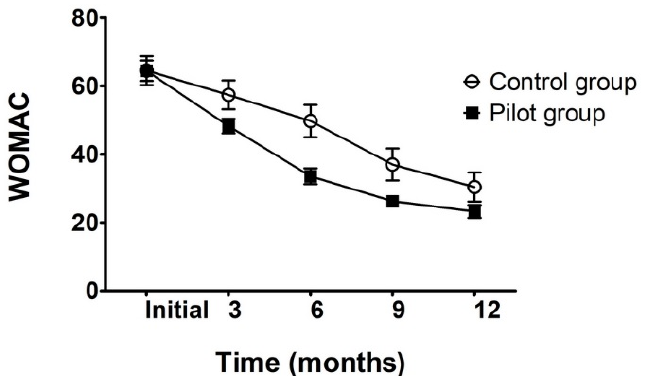
Figure 7. Western Ontario and McMaster Universities Osteoarthritis Index (WOMAC) total scores